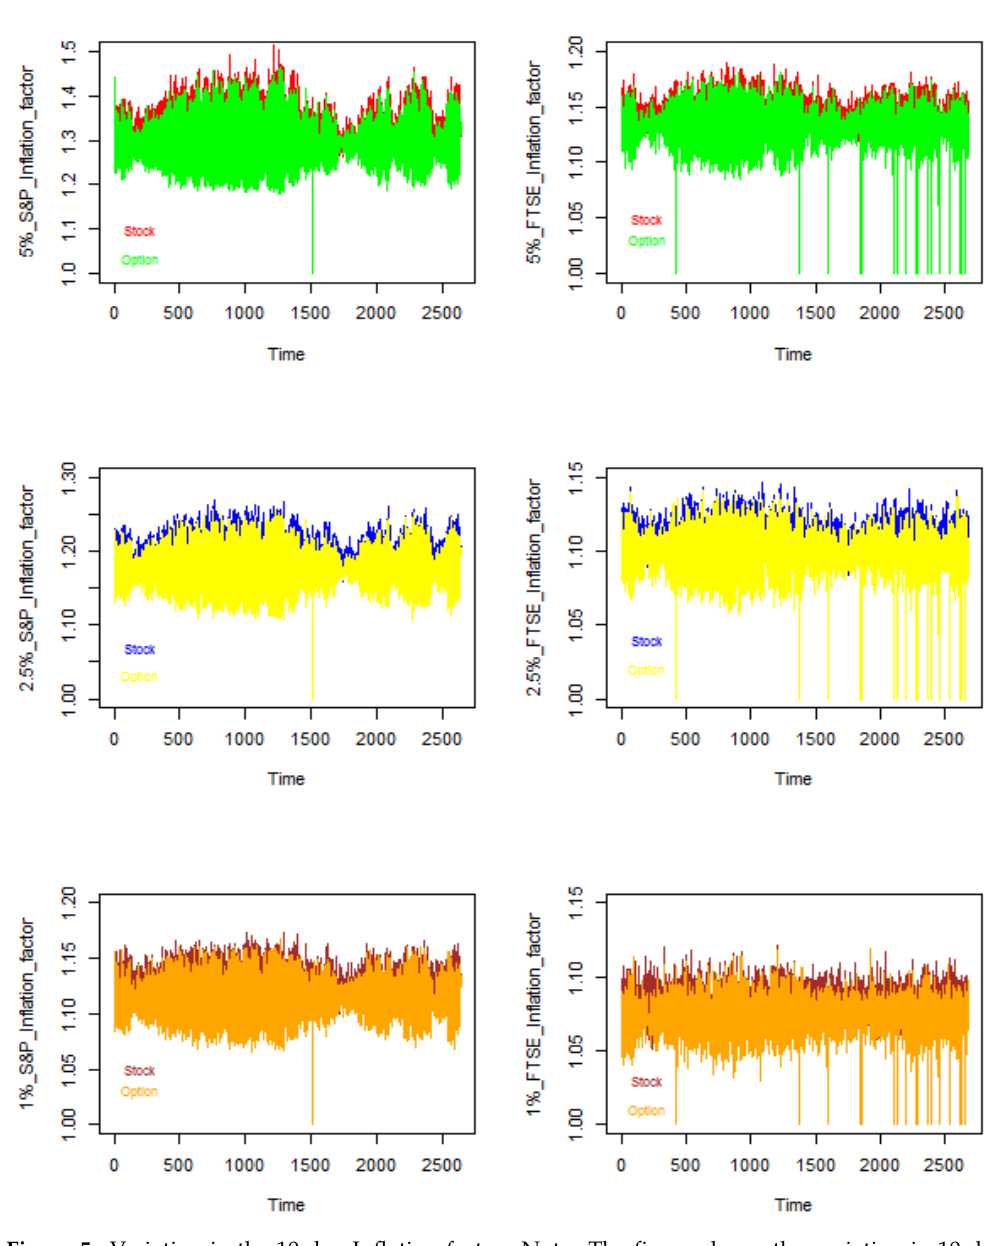
Figure 5. Variation in the 10-day Inflation factor. Note: The figure shows the variation in 10-day MaxVaR to VaR ratio for S&P 500 stock returns and FTSE 100 stock returns and the P&L of the corresponding 30-day index options at various significance